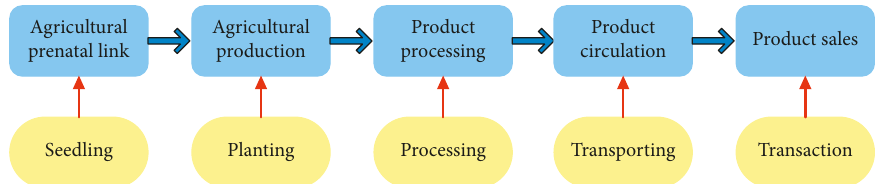
Figure 1: Composition diagram of agricultural industrial chain structure.